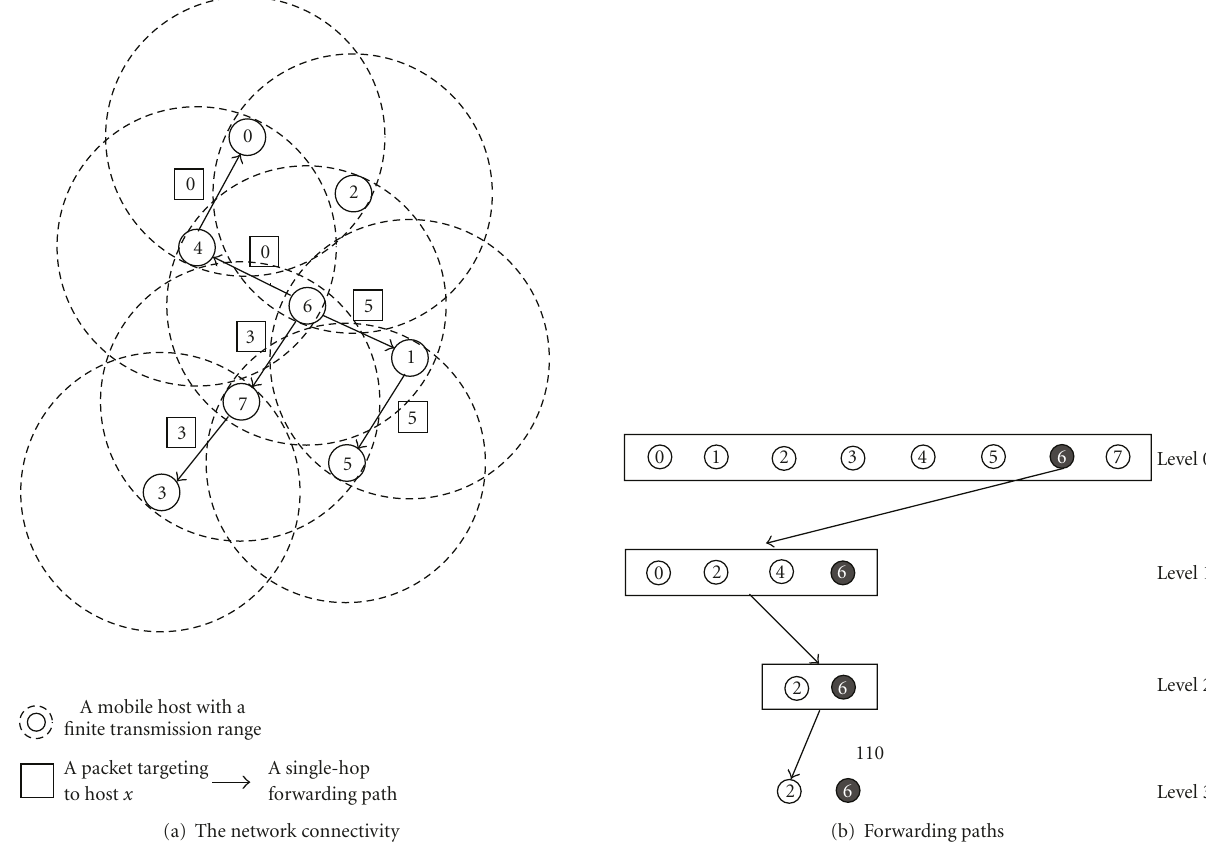
Figure 2: The paths for forwarding location queries made by host